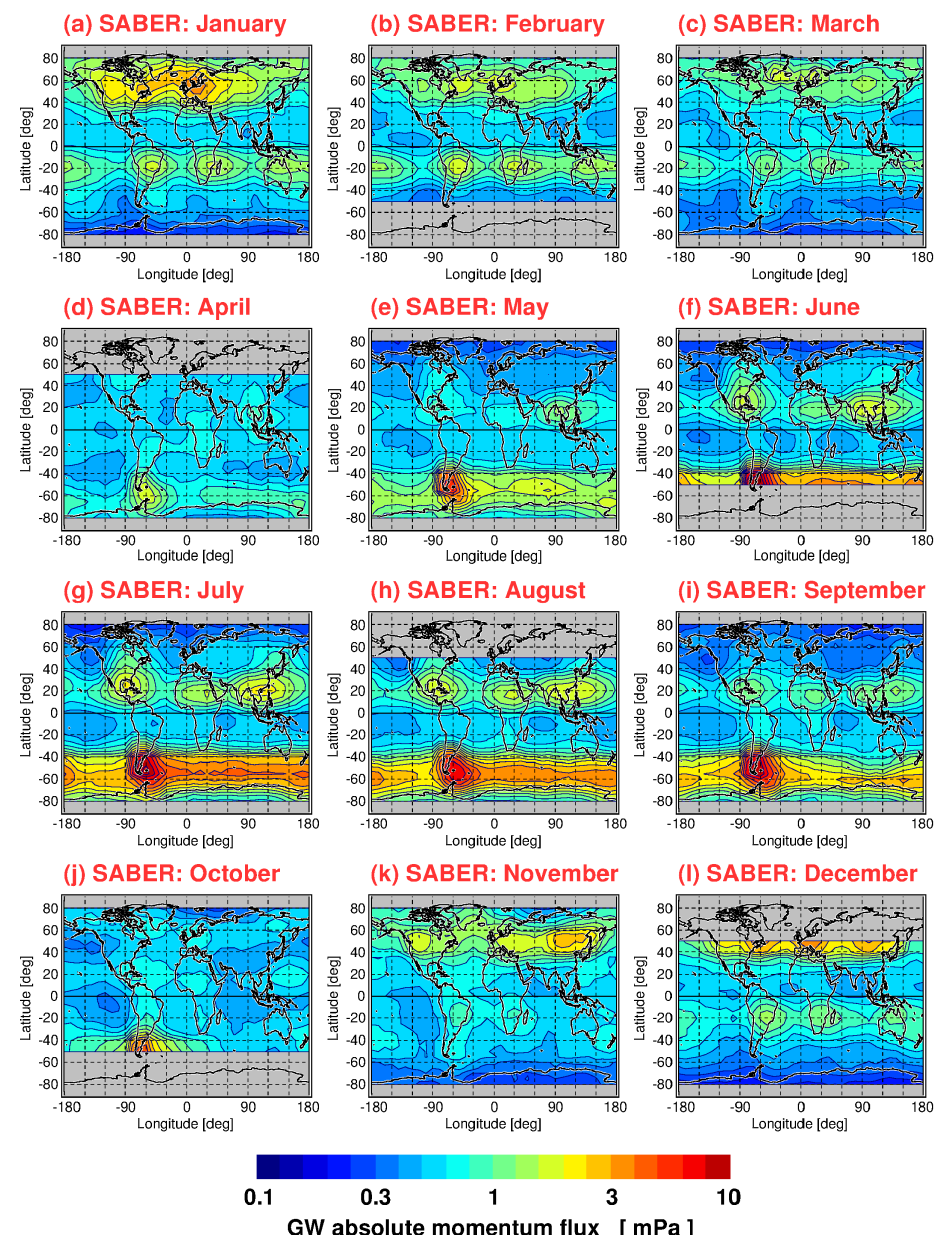
Figure 13. Global distributions of gravity wave absolute momentum fluxes at 30km altitude. Shown are 13-year averages for SABER for each calendar